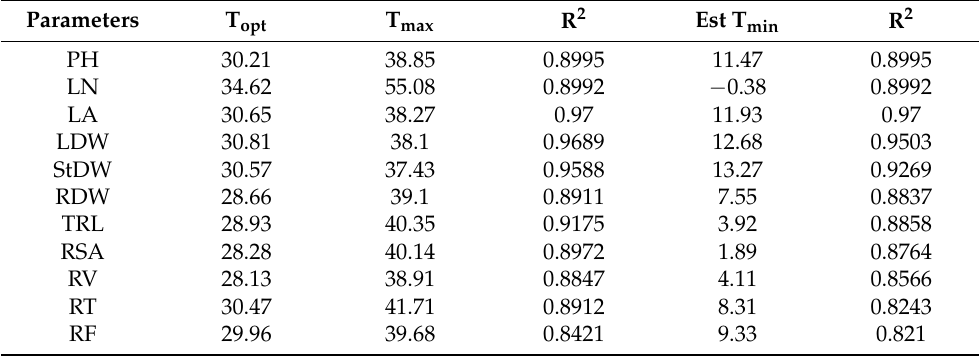
Table 3. Modified beta function parameter estimates and cardinal temperatures (T opt and T max